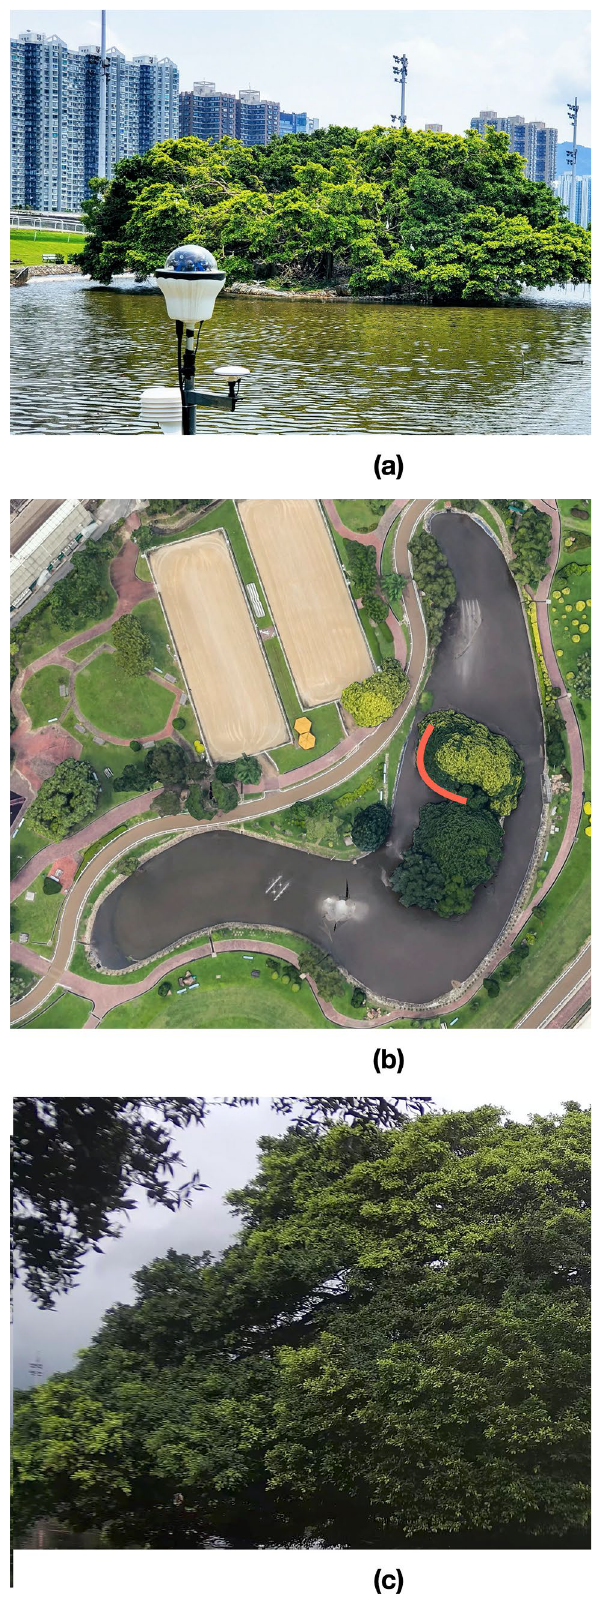
Figure 1. Penfold Park, the study site: ( a ) Green AI camera used to automatically record bird videos at this study site; ( b ) aerial view of the study site. The orange region represents the viewpoint of Green AI Camera; and ( c ) trees at the centre of the pond, which is the background image recorded by Green AI